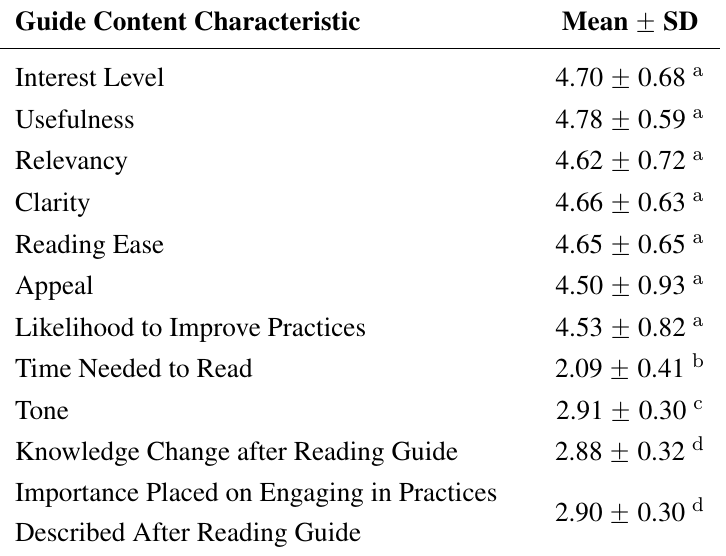
Table 4. Cognitive testing content participant rating of HomeStyles